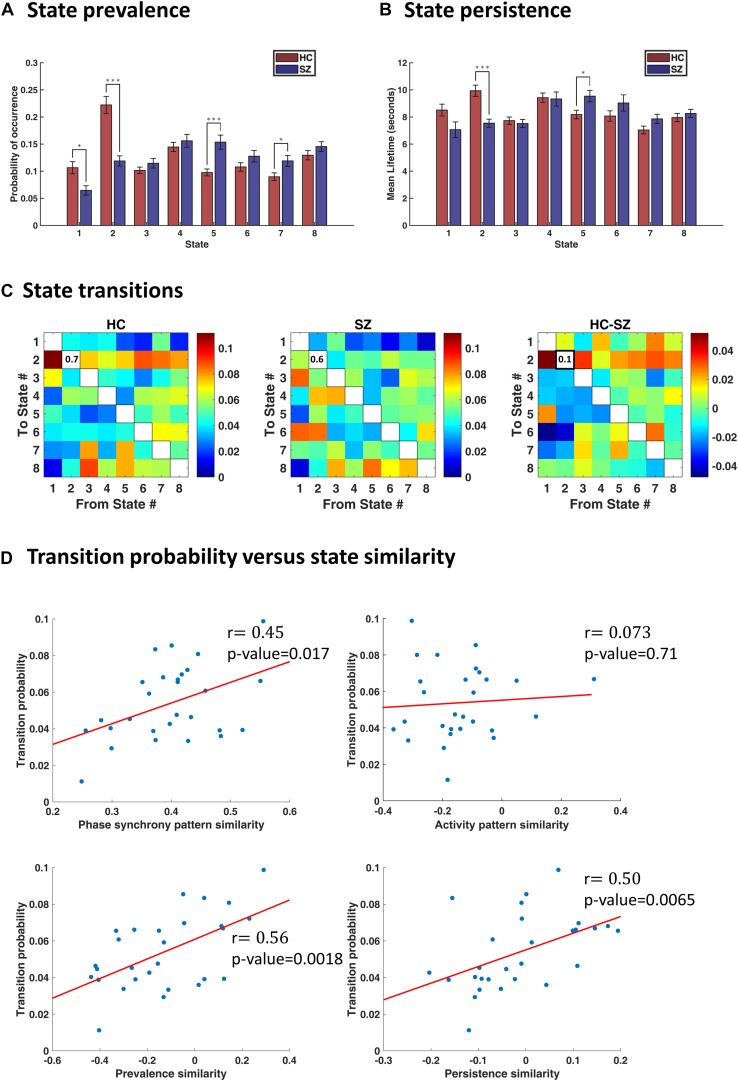
Characterization of transience in IPS states. (A) State prevalence (i.e., probability of occurrence) for each state, in the healthy control (HC) and schizophrenic (SZ) group. Error bars denote standard errors of mean (SEM). Group differences were assessed using permutation-based t tests. States 1 and 2 are more frequently visited by the HC, whereas states 5 and 7 are more prevalent in the patient group. (B) Persistence (i.e., mean lifetime) of each state, per group. The HC remain longer (continuously) in state 2, whereas SZ subjects prefer to linger in state 5. (C) Group-average transition patterns and their difference (HC–SZ). Diagonal values have been removed to improve image contrast. Only one entry (i.e., the probability of dwell in state 2) is significantly different after FDR correction. (D) Relationship between transition probability and state similarity. State similarity is assessed from four aspects: IPS pattern similarity, activity map similarity, prevalence similarity, and persistence similarity. Activity map resemblance is uncorrelated with transition probability between states; however, similarity in the other three functional and temporal aspects of the states significantly correlates with the probability of switching between them. The correlation coefficient (r) is imprinted beside each plot, and red lines denote best fitted lines. In panels (A,B), asterisks show statistically significant differences, after FDR correction (∗ indicates p < 0.05; ∗∗∗ indicates p < 0.001).